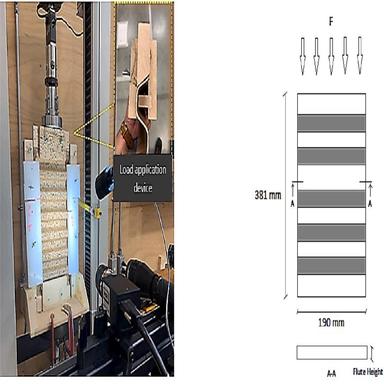
Transverse compression test with the use of a digital correlation camera to measure the deformation.